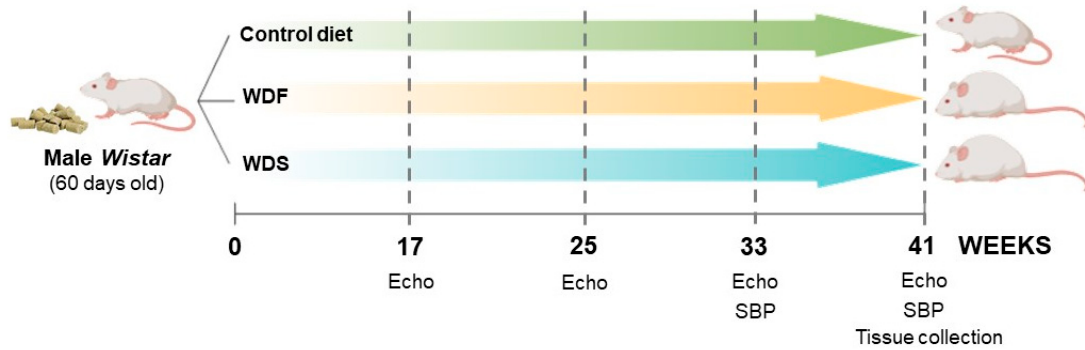
Figure 1. Schematic representation of the experimental design for the study of the effects of dietary interventions using a rat model. WDF and WDS: Western diet fat and sugar, respectively. Echo: echocardiographic analysis. SBP: systolic blood pressure.